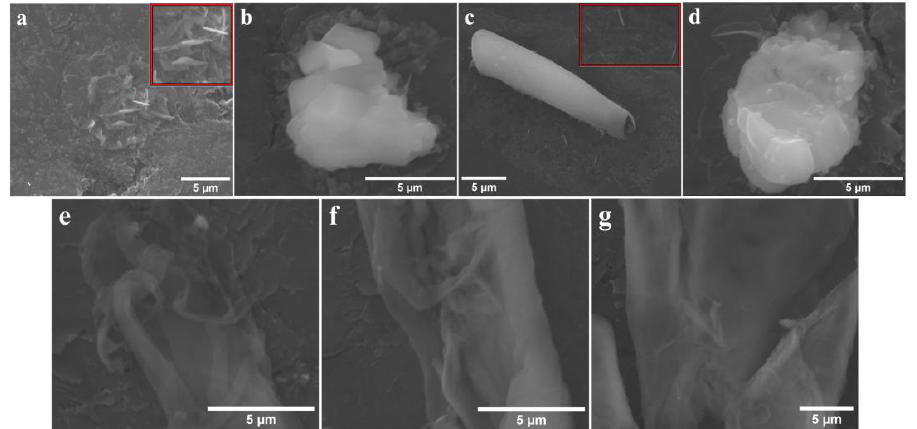
Figure 10. SEM micrographs recorded on the G P1-DMF-3 modified electrode before the stability test ( a